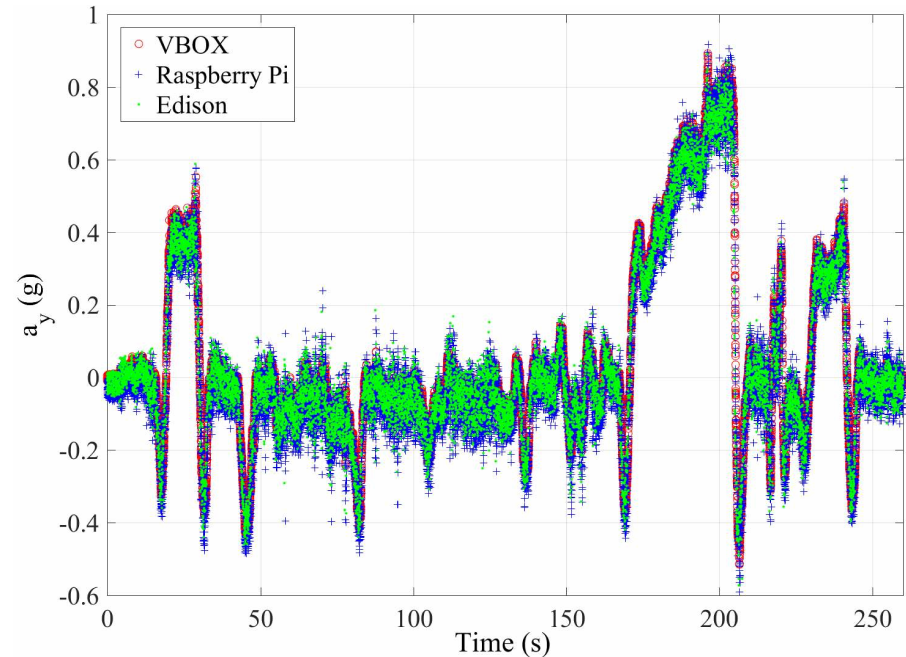
Figure 15. Test 3: Lateral acceleration obtained from the IMU of VBOX (red points), from the IMU of Raspberry pi (blue points) and from the IMU from Intel Edison (green